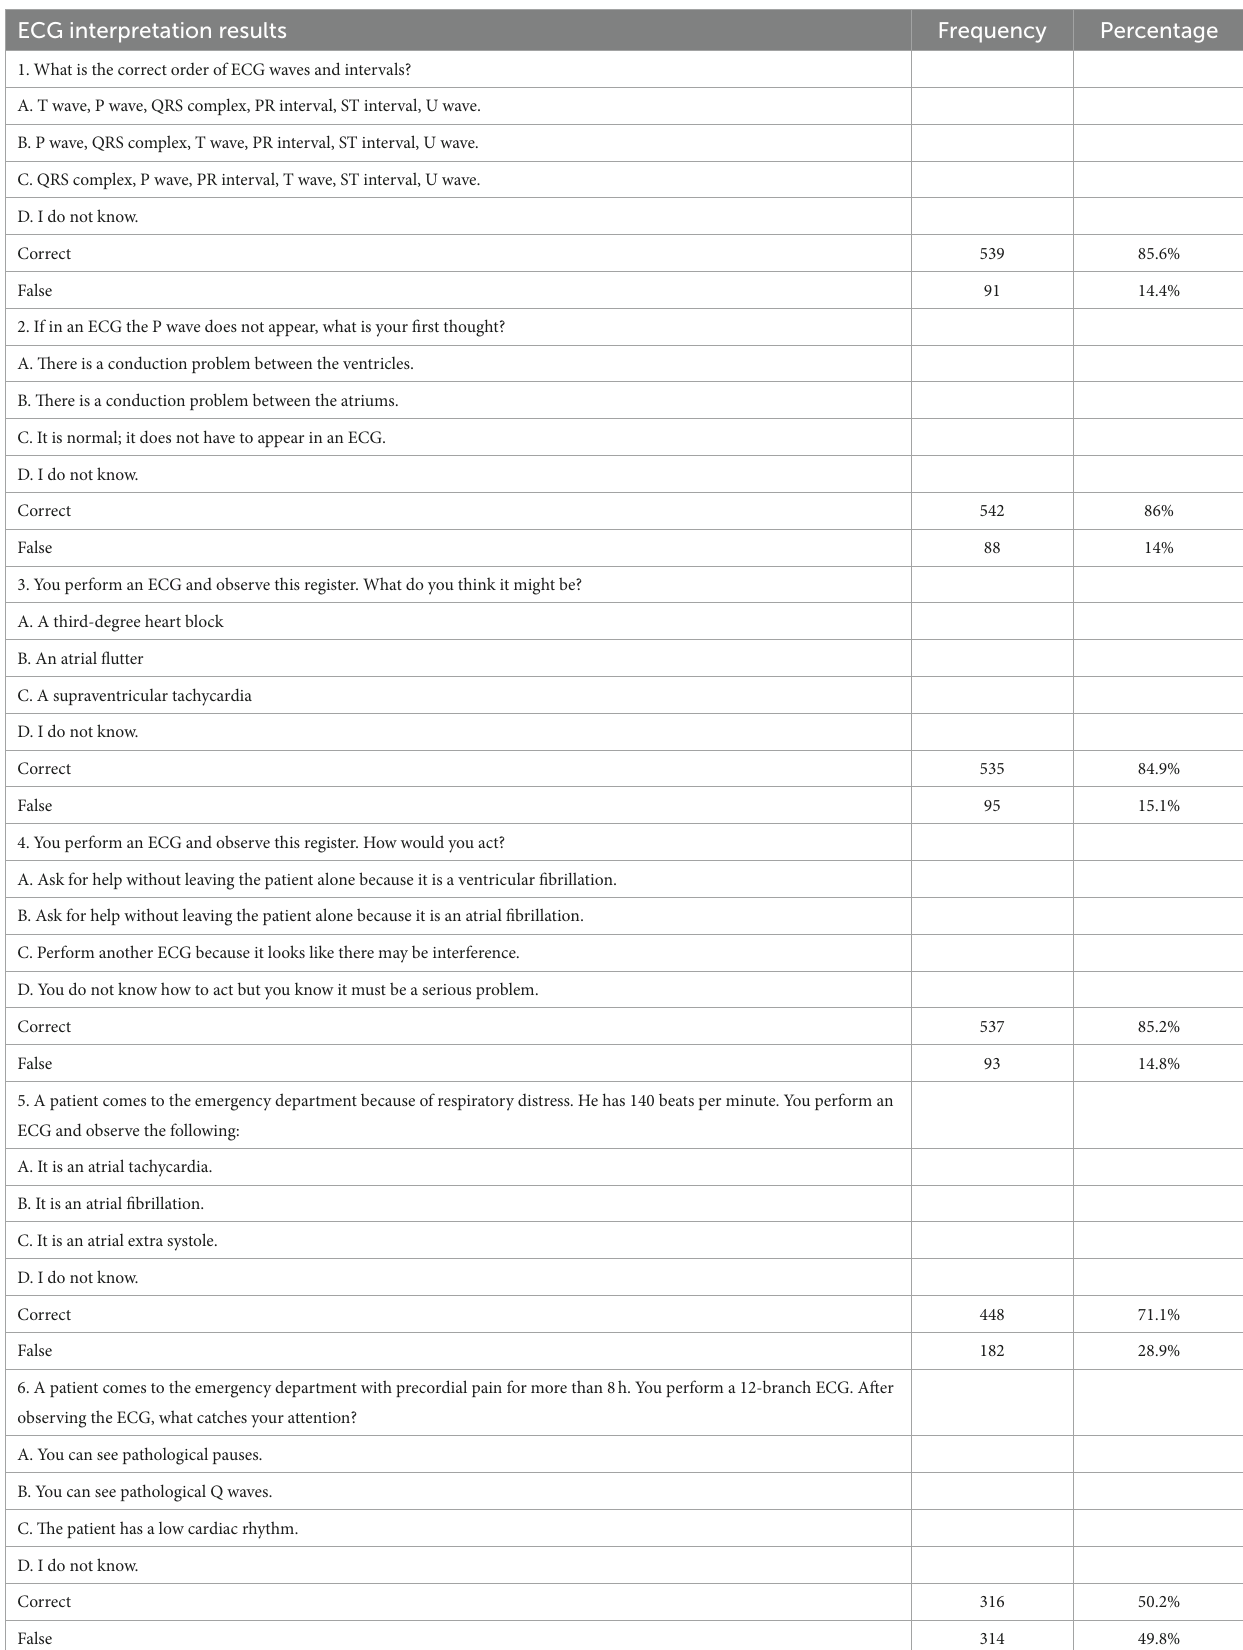
TABLE 2 ECG interpretation